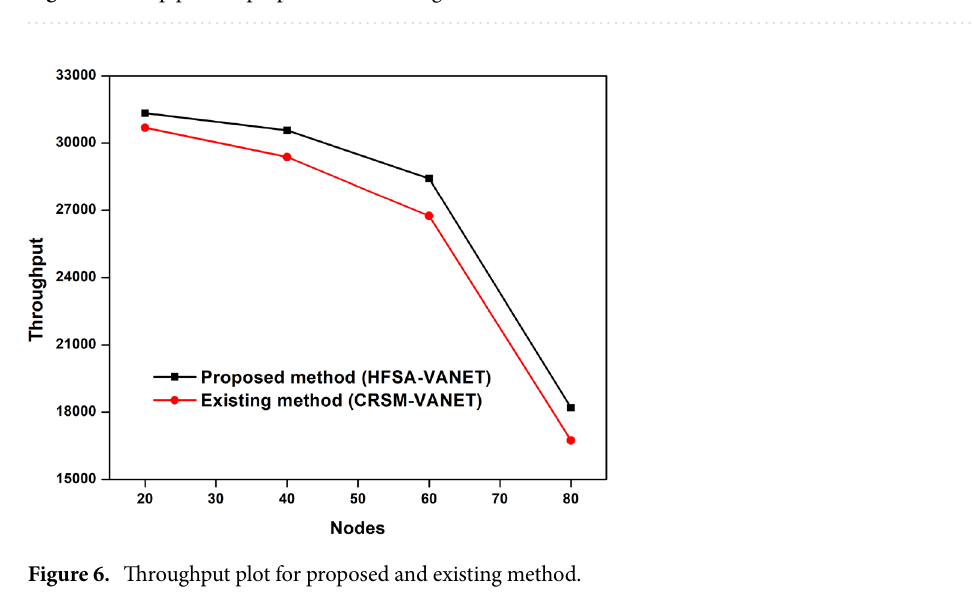
Figure 5. Drop plot for proposed and existing method.